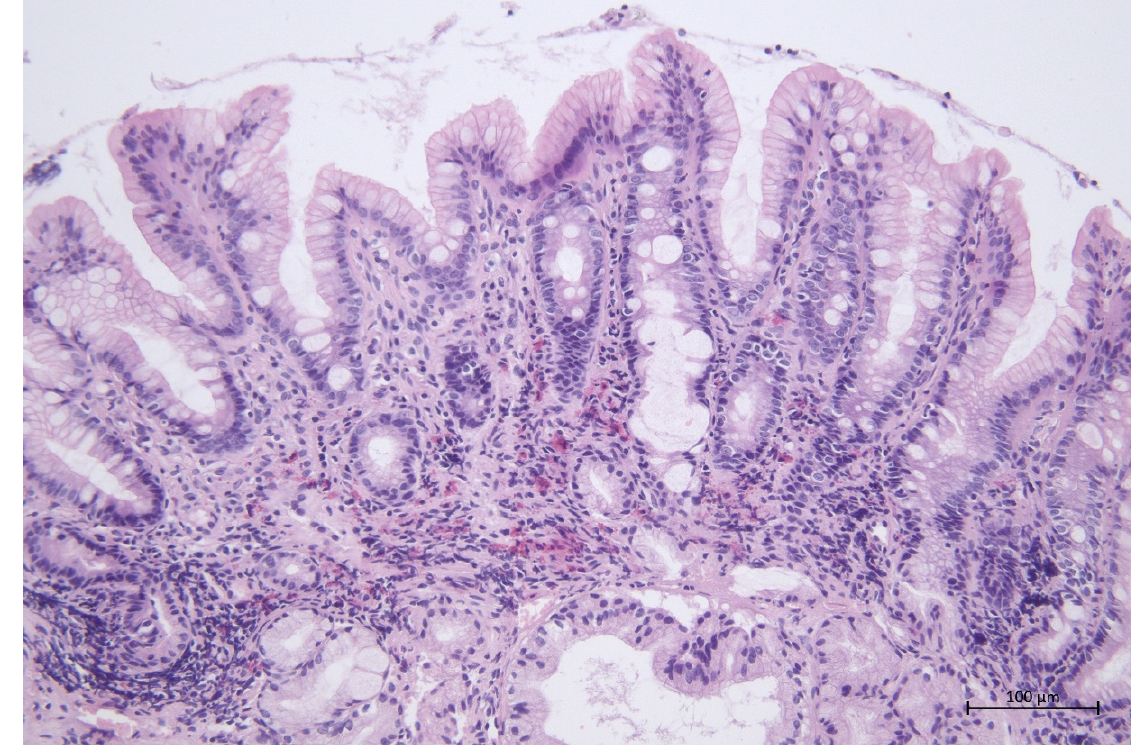
Figure 3. Eosinophilic duodenitis, 200× magnification.